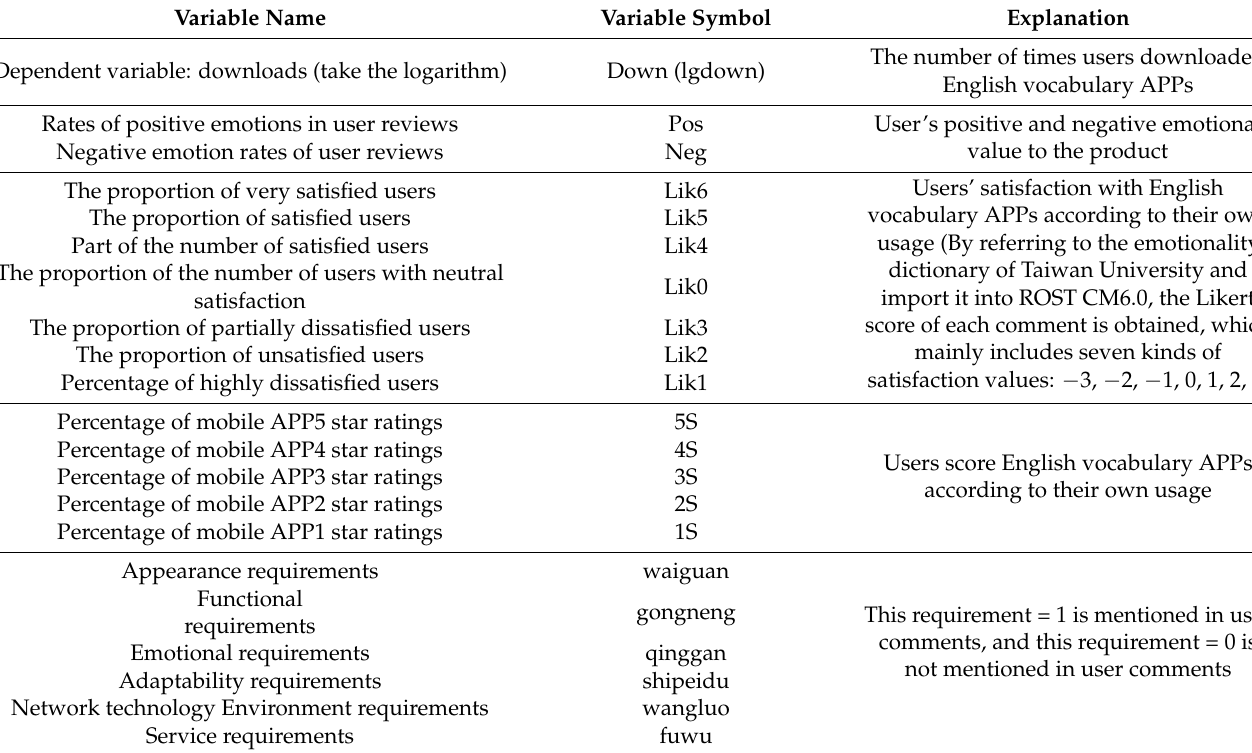
Table 11. Variable description of quantile regression model for English vocabulary APP